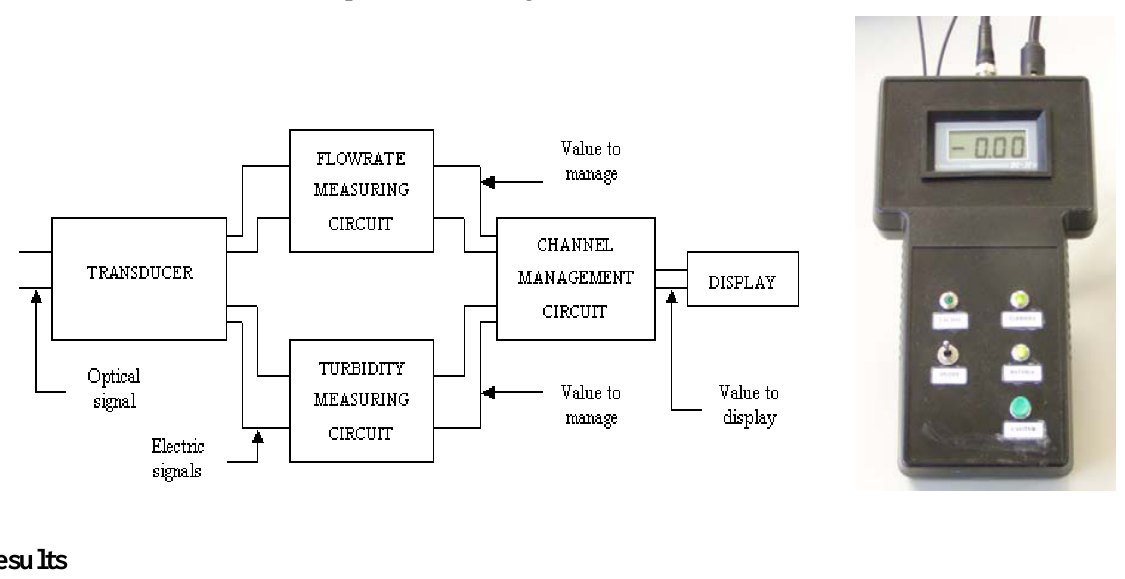
Figure 5 . Complete block diagram and unit control for the sensor.